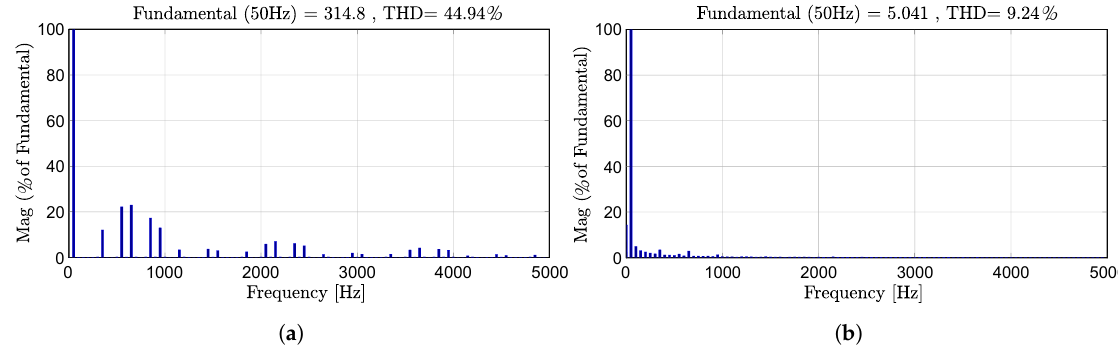
Figure 9. ( a ) THD of full bridge legs output voltage; ( b ) THD of the load